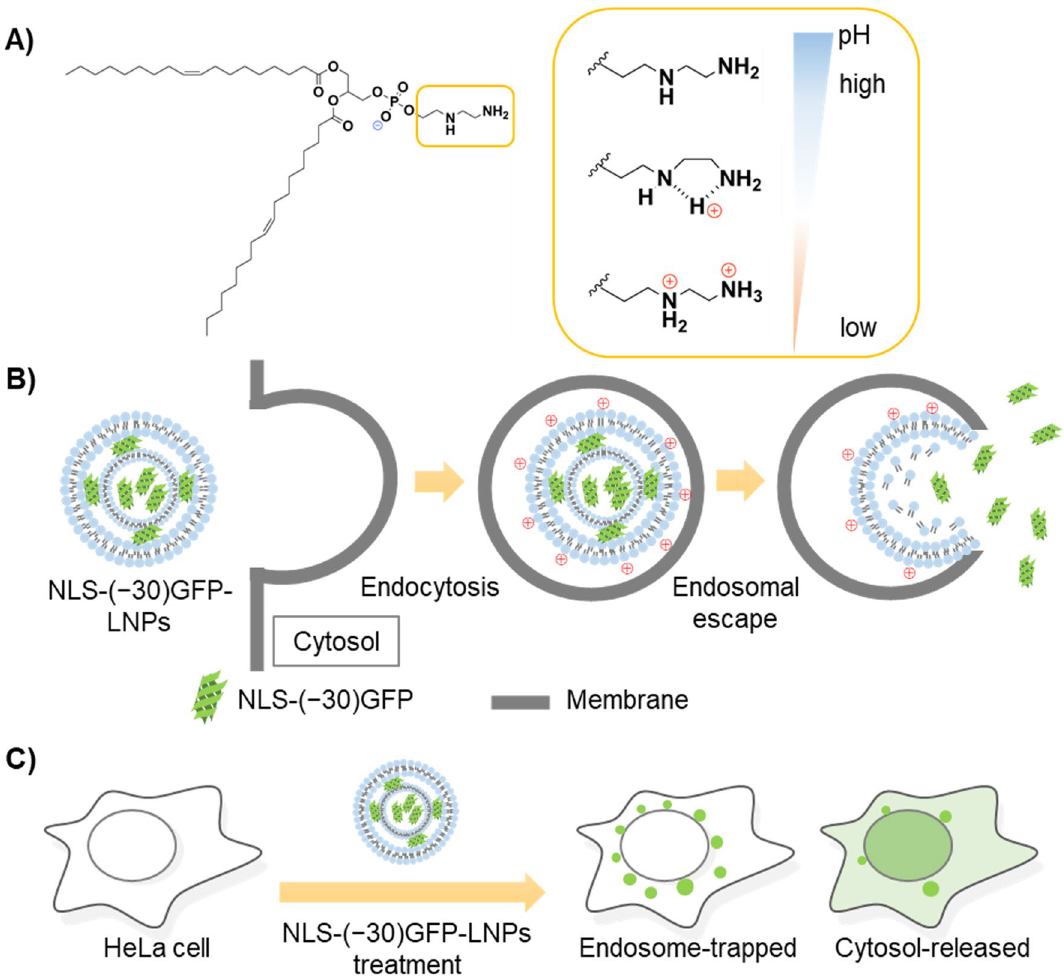
Figure 1. ( A ) Dioleoylglycerophosphate-diethylenediamine (DOP-DEDA) as a pH-sensitive, charge-reversible lipid and ( B ) hypothesized scheme of packaging and intracellular delivery of NLS-(− 30)GFP by DOP-DEDA- based carriers [NLS-(− 30)GFP-LNPs]. ( C ) Schematic illustration of the signals from endosome-trapped and cytosol-released NLS-(−